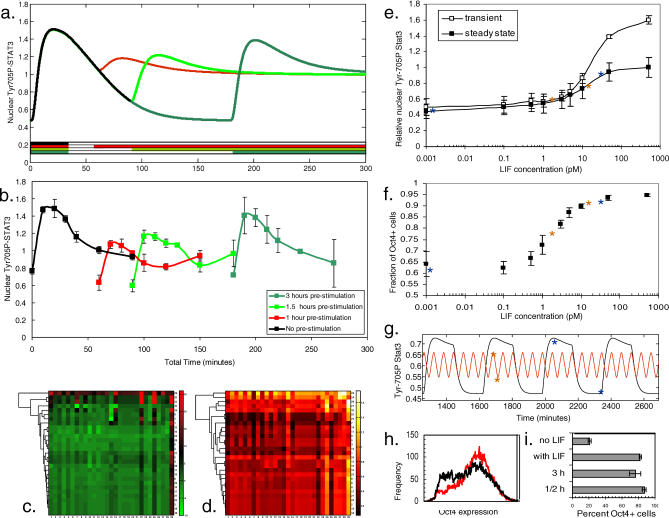
Desensitization of ESCs to LIF Stimulation Can Be Investigated Computationally and Used to Control Self-Renewal(A) Model-predicted trends of desensitization of Stat3 activation to LIF stimulation. Color bar inset shows history of 500 pM LIF stimulations.(B) Experimental results are in agreement with model-predicted desensitization kinetics in (A) and show a gradual loss of desensitization in absence of ligand.(C) Global sensitivity analysis shows parameter interactions which result in right-shift (positive minutes) or left-shift (negative minutes) in restimulation profile of Stat3. Shift in the profile was determined from the maximum of cross-correlation of two consecutive Stat3 activation profiles.(D) Sensitivity analysis clustergram shows Euclidean distance measurement between two consecutive Stat3 activation profiles and distinguishes parameter interactions which influence desensitization by changing the restimulation profile.(E) Experimental results of dose response of Stat3 activation to LIF show the steady state response as well as the peak values of Stat3 activation during transient LIF stimulation.(F) Dose response of Oct4 expression after 72 h at different LIF concentrations.(G) Stat3 activation profiles for 10 pM LIF stimulation with 1-h and 6-h periods in red and blue, respectively. During 6-h cycles, LIF is removed for 3 h during which time a lower Stat3 activation level is observed in comparison with the 1-h period.(H) Histograms of Oct4 expression show that 1-hr period of LIF stimulation (red) maintains a higher percentage of Oct4+ cells than 6-h period of LIF stimulation after 72 h.(I) Oct4 expression of cells maintained for 72 h in different conditions shows that the percentage of Oct4+ cells in the 1-h period is higher than the 6-h period and comparable to 500 pM constant LIF levels.